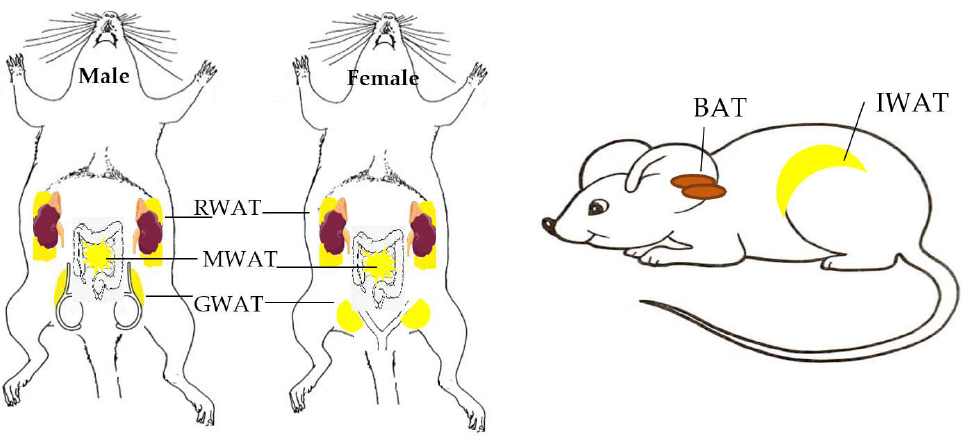
Figure 2. Schematic overview of location of di ff erent types of white and brown adipose tissues. Schematic diagrams indicating locations of di ff erent types of commonly studied WAT and BAT in male and female rodent models, including visceral RWAT, MWAT, and GWAT, as well as subcutaneous IWAT and interscapular